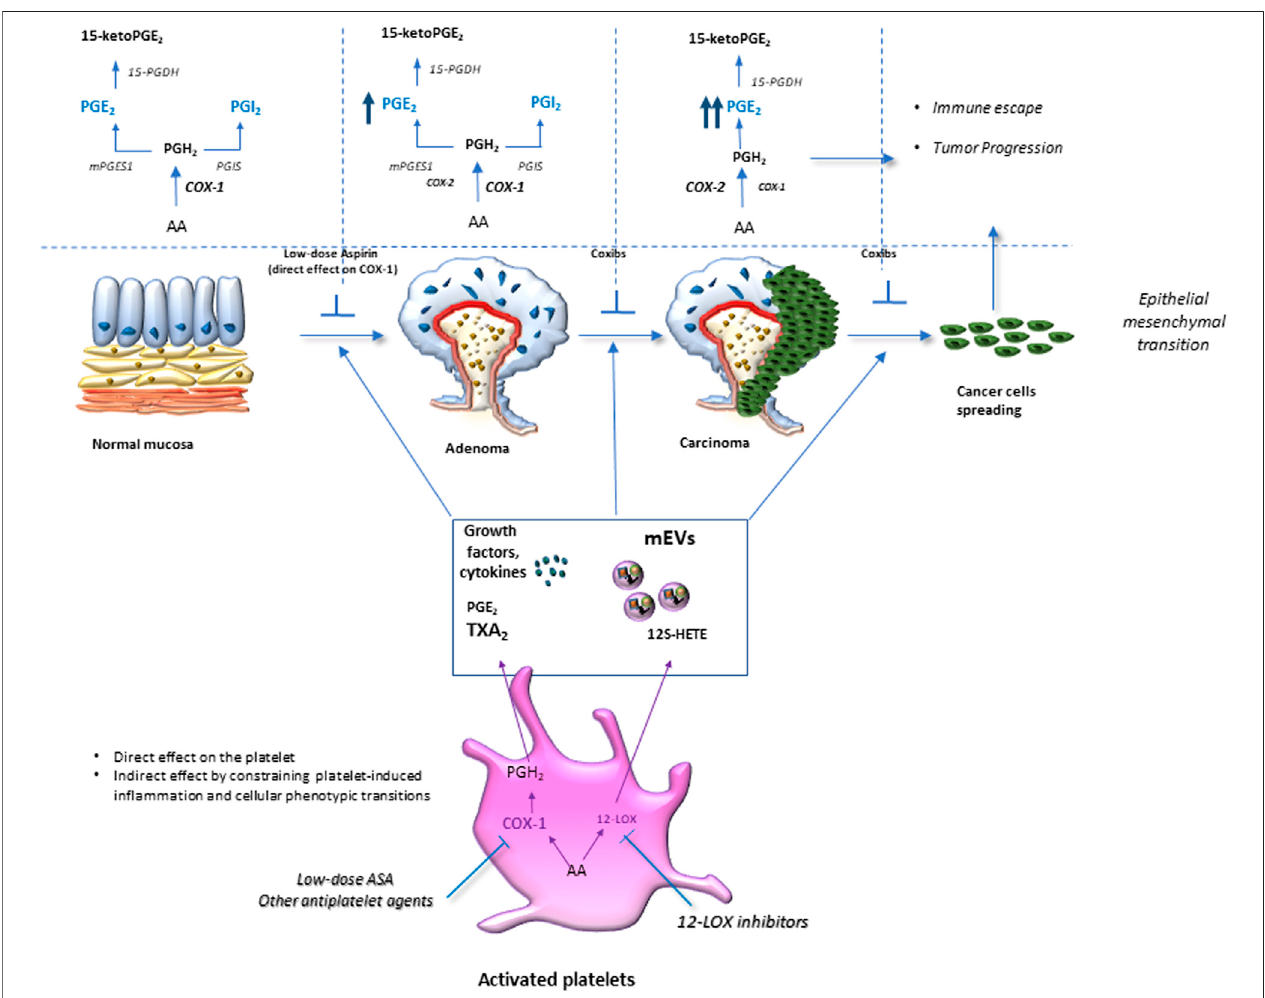
FIGURE 3 | Platelet activation in response to intestinal damage is crucial in chronic in fl ammation/ fi brosis. Platelet activation in response to intestinal epithelial damage contributes to acute in fl ammation by promoting leukocyte recruitment to restore normal tissue function. However, exaggerated platelet activation isassociated with an elevated release of thromboxane (TX) A 2 and prostaglandin (PG)E 2 , growth factors, angiogenic factors, cytokines, and chemokines, as well as medium-sized extracellular vesicles (mEVs) rich in genetic material (mRNAs and microRNAs). Thesefactors activate stromal cells (such as myo fi broblasts and immunecells), thus increasing the production and release of growth factors and in fl ammatory mediators, including PGE 2 , due to cyclooxygenase (COX)-2 induction. Platelet-derived TXA 2 induces phenotypic and functional changes in myo fi broblasts, such as the reduction of α -Alpha Smooth Muscle Actin (SMA) and the increase of vimentin fi bronectin RhoAexpression; theseeventsleadtoanenhanced capacitytoproliferate andmigrate,thus,contributingtochronicintestinalin fl ammation and fi brosis.Theinhibitionof platelet COX-1 activity (by low-dose Aspirin) or blocking the TXA 2 receptor (TP) can mitigate chronic intestinal in fl ammation and fi brosis.